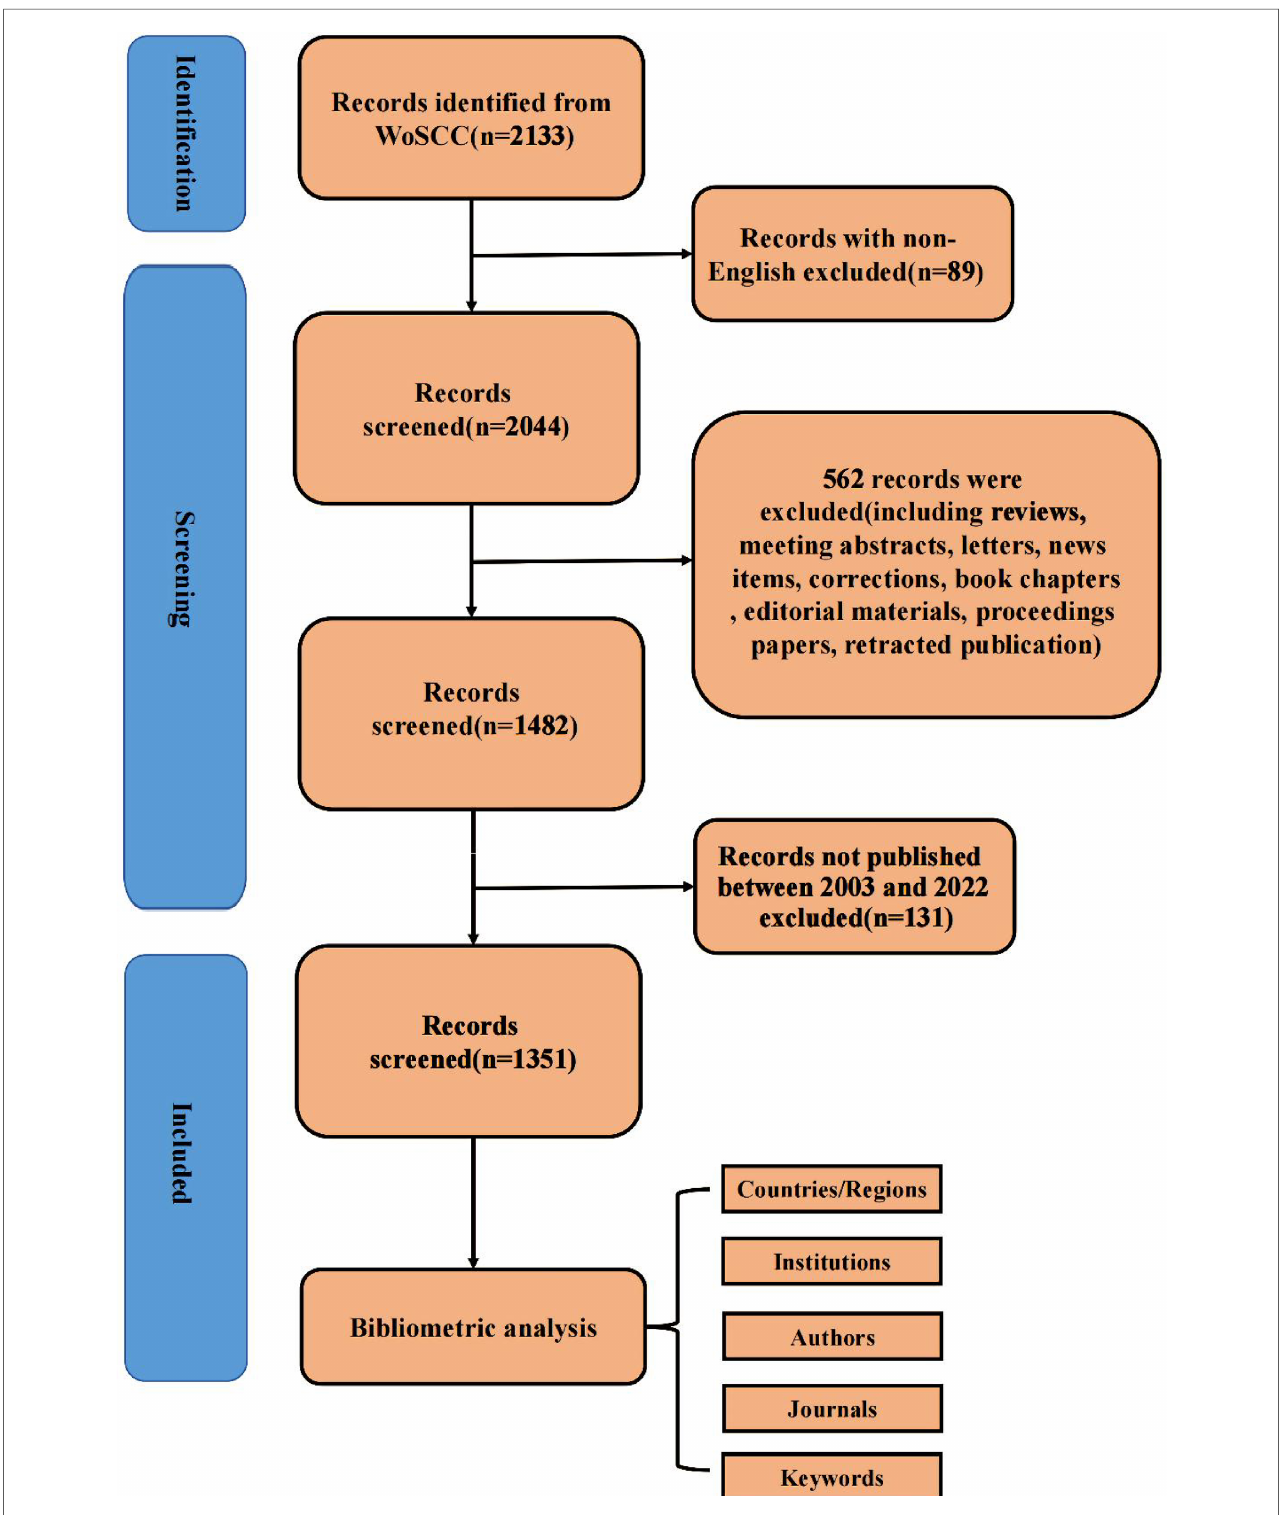
FIGURE 1 Flowchart of literature